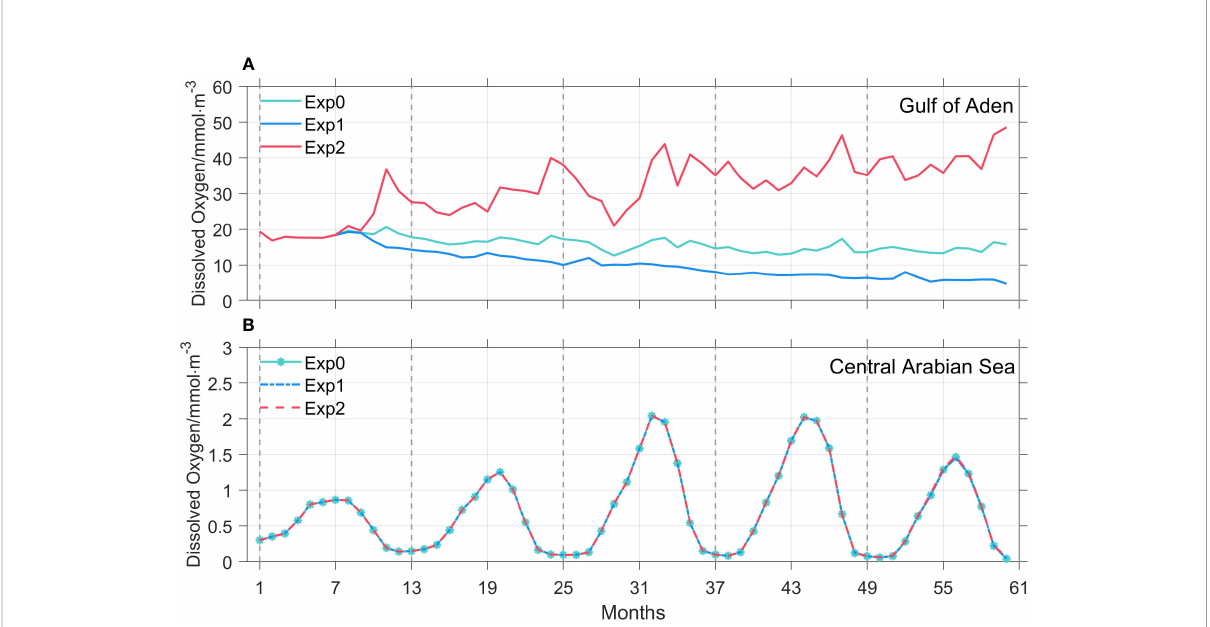
FIGURE 9 Time series of averaged dissolved oxygen concentration at site A ( A ; Gulf of Aden) and site B ( B ; central Arabian Sea) from three experiments (Exp0, Exp1, and